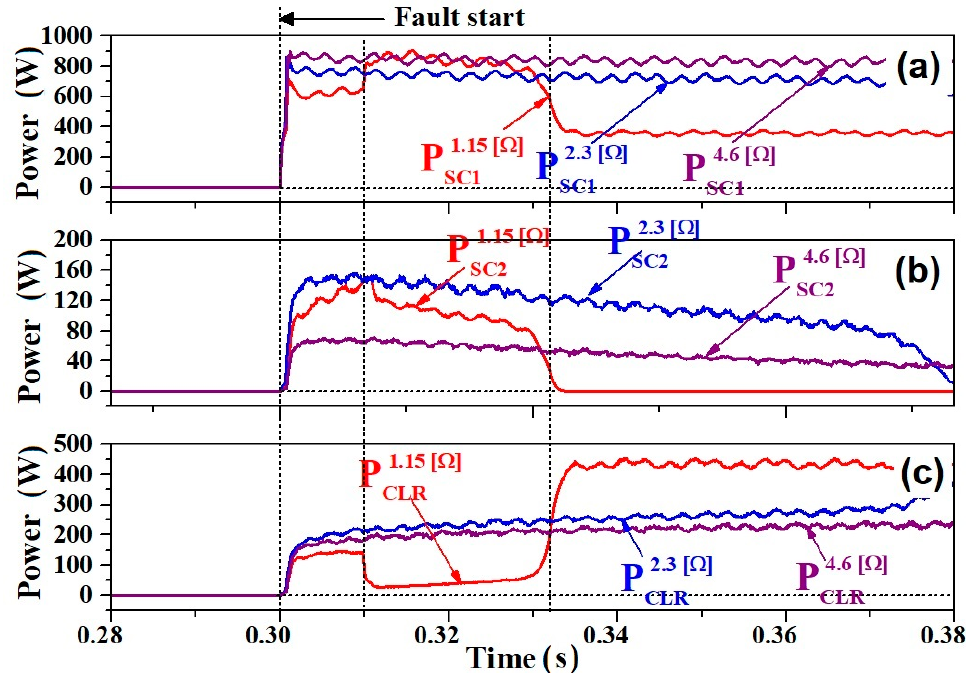
Figure 6. Instantaneous power waveforms due to the CLR’s resistance: ( a ) power burden arising from R SC1 element depending on the CLR’s resistance; ( b ) power burden arising from the R SC2 element depending on the CLR’s resistance; ( c ) power burden arising from the CLR depending on the CLR’s resistance. Energies 2020 , 13 , x FOR PEER REVIEW